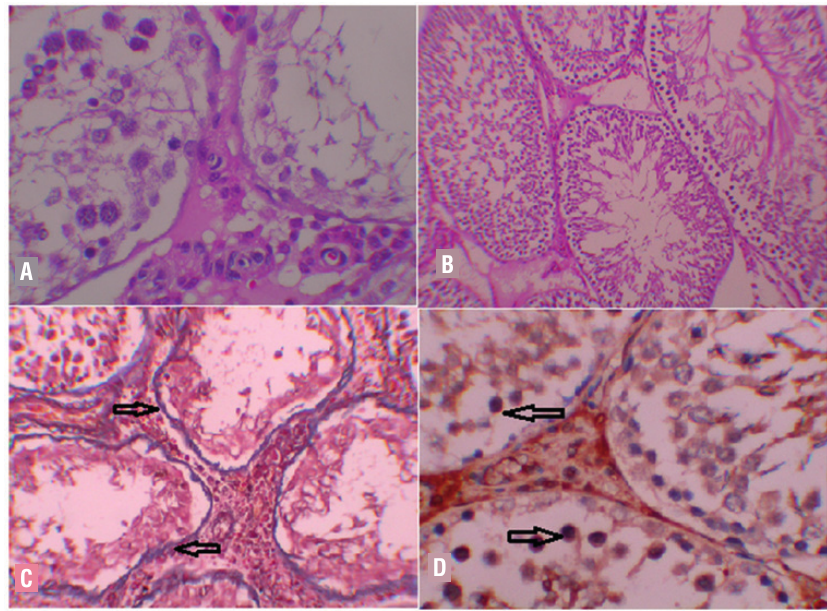
figure 2 A) I/R group, right testicle: Spermatogenesis arrest at spermatocyte level and seminiferous tubules containing only Sertoli cells (H&E x400). B) DpO/Td combination group, Right Testicle: Regular sized seminiferous tubules with slightly decreased Johnsen score (H&E x100). c) I/R Group; Right Testicle M-T: Severe fibrosis on basal membrane of deformed seminiferous tubules (arrow)(M-T x200). D) I/R group, caspase-3, Right testicle: Staining on several germ cells (arrow)(IHk